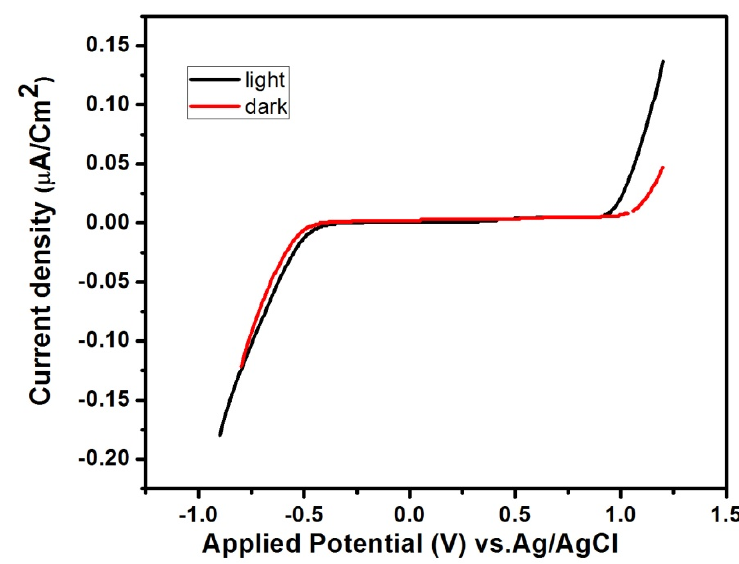
Figure 5. Light and dark current density of MgCr − LDH (3:1, 80 °C).